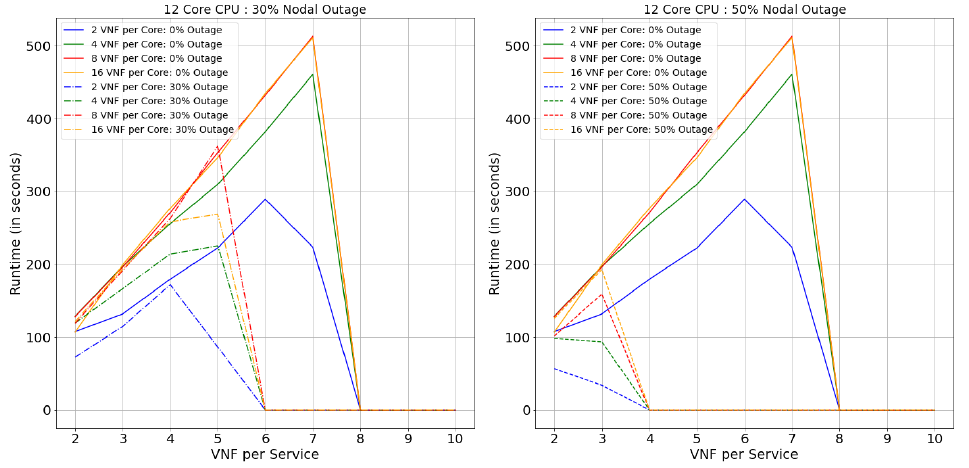
Figure 23. Runtime: Netrail topology with nodal uutage—8 core CPU.